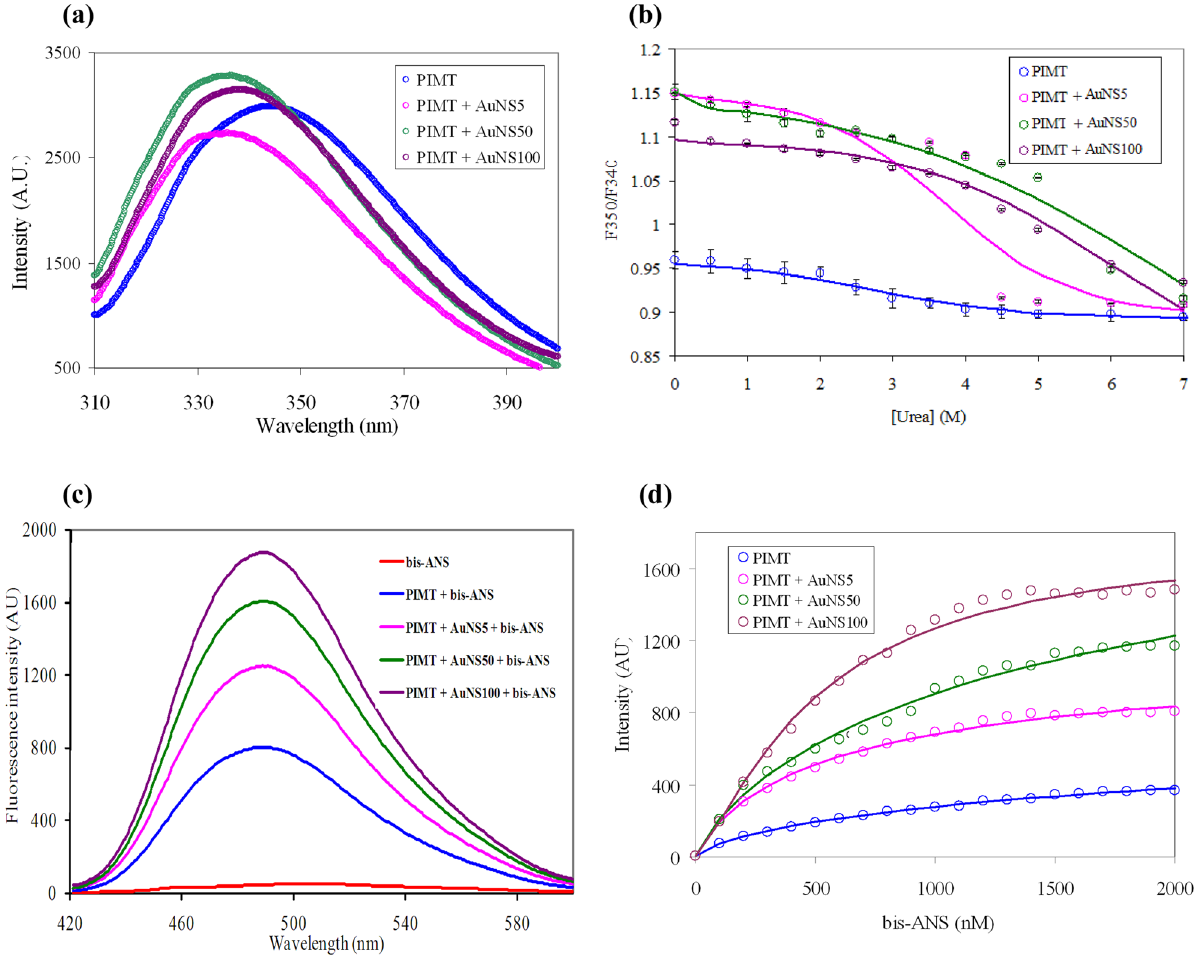
Figure 1. ( a ) Fluorescence spectra and ( b ) urea-induced unfolding of PIMT and PIMT in presence of AuNSs of different sizes in 1:1 molar ratio. Samples were excited as 295 nm in 0.1 M sodium phosphate buffer pH 7.2. ( c ) Fluorescence spectra of bis-ANS alone, and in presence of PIMT and PIMT-AuNS conjugates (in 1:1 molar ratio) in presence of bis-ANS. Protein concentration of 5 μM was used and the samples were excited at 395 nm. ( d ) Titration using fluorescence intensity against bis-ANS concentration, in presence of PIMT and PIMT-AuNS conjugates.